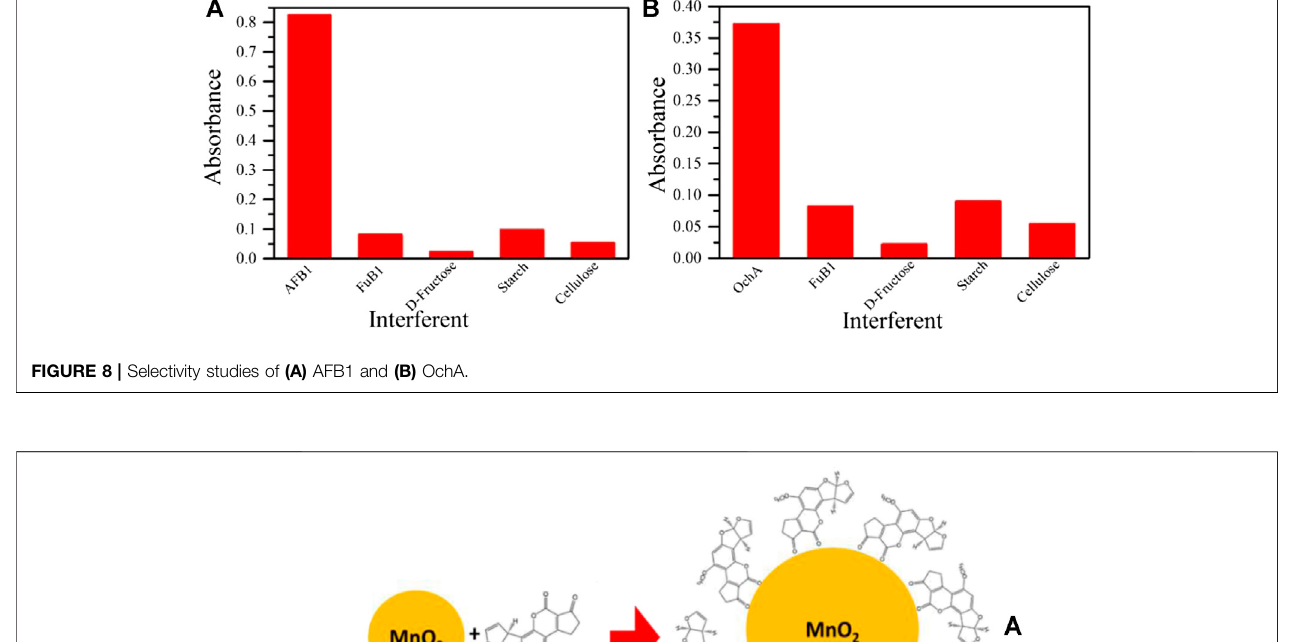
Frontiers in Nanotechnology |